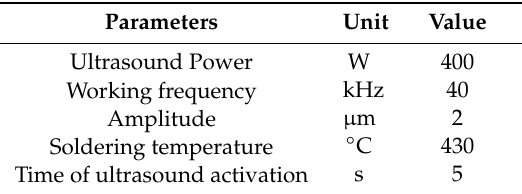
Table 2. Soldering